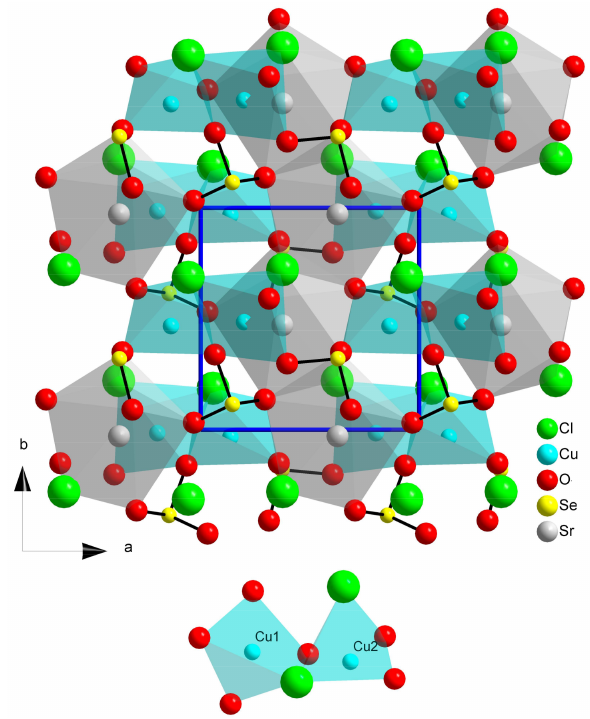
Figure 4. Crystal structure of SrCu 2 (SeO 3 ) 2 Cl 2 [27]. The [Cu 2 O 4 Cl 2 ] dimer is shown separately at the bottom part of the